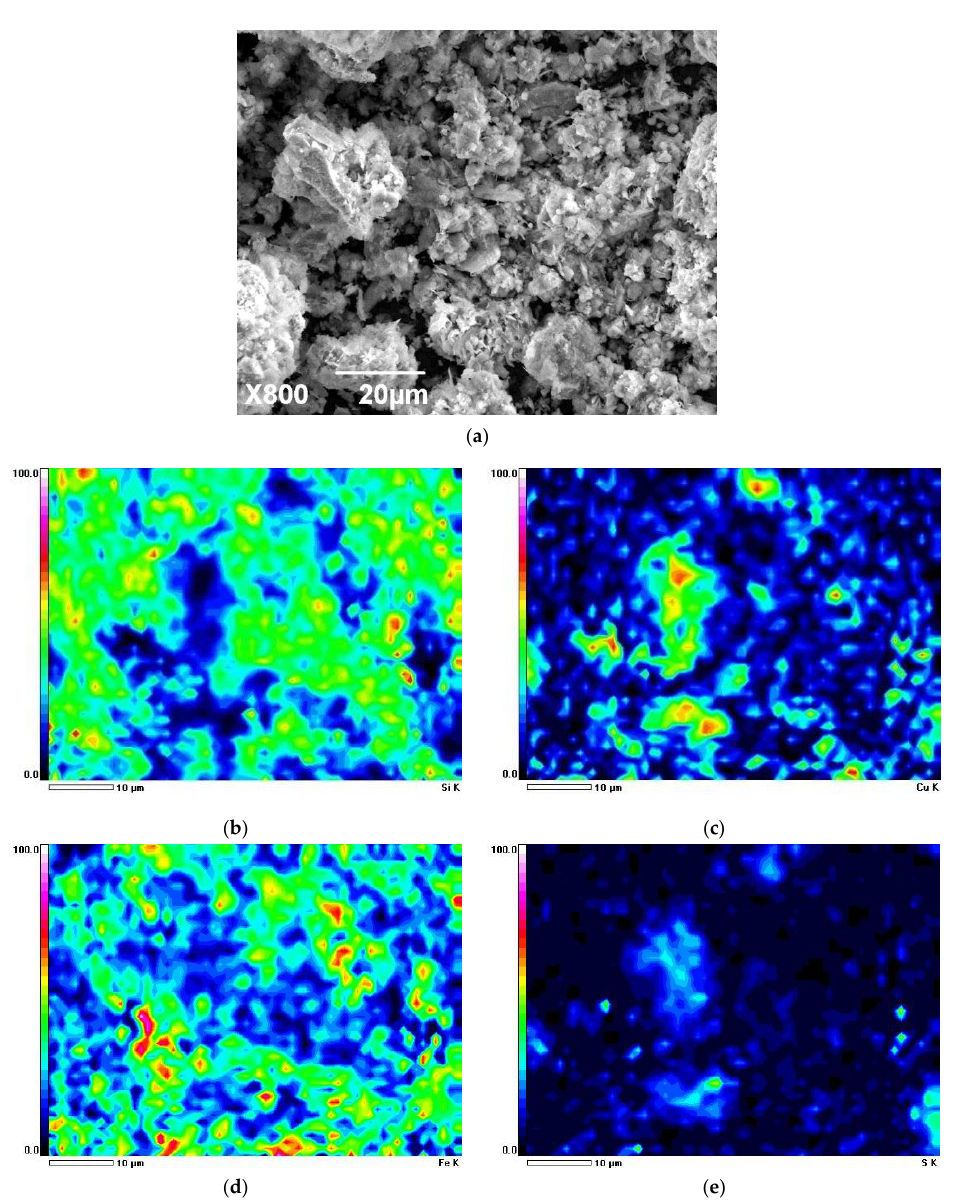
Figure 12. SEM image of desilicated concentrate ( a ), and map-scans ( b – e ) for Si, Cu, Fe and S, respectively.